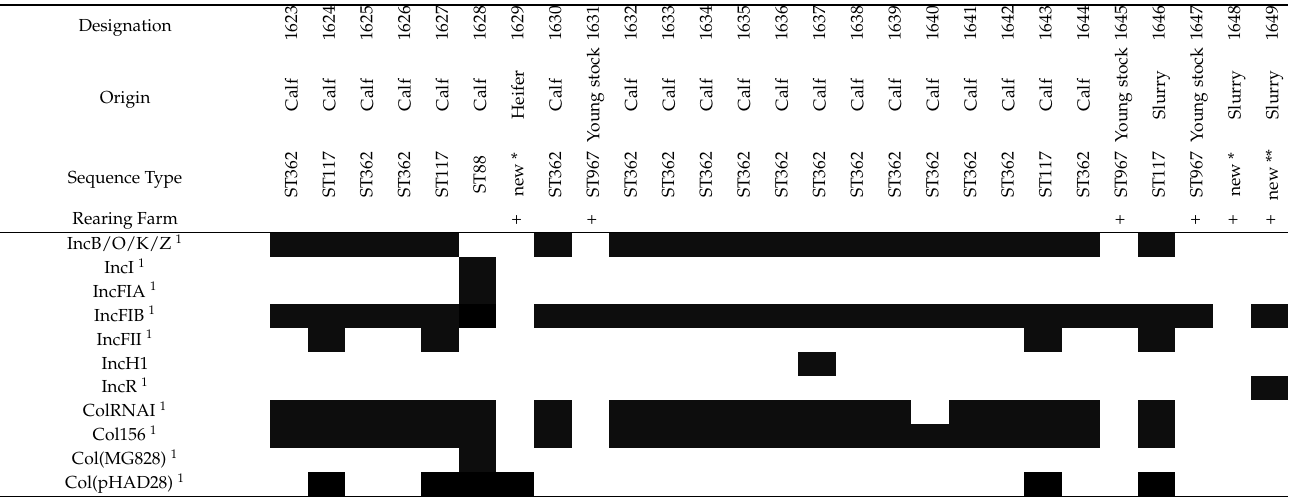
Table 1. Genotypic characterization of sequenced ESBL- E. coli isolates; presence of a certain factor is based on the results from ABRicate [ABRicate v. 1.0.0 (https://github.com/tseemann/abricate, accessed on 1 April 2022), databases used: VFDB, ResFinder, PlasmidFinder, BacMet, ARG-ANNOT, and Ecoli_VF] using de novo-assembled sequences and is depicted in black. Detected genes are assigned to the following categories: 1 Plasmid replicon types, 2 aminoglycosides, 3 beta-lactam antibi- otics, 4 phenicol antibiotics, 5 sulfonamides and trimethoprim, 6 tetracycline antibiotics, 7 macrolide, lincosamide, and streptogramin